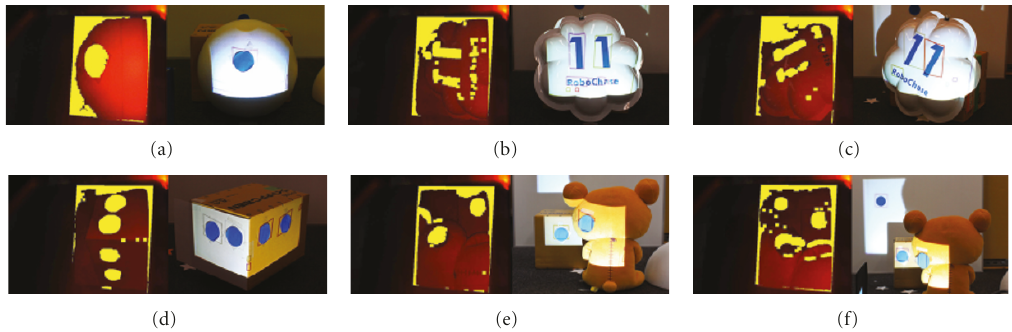
Figure 12: Demonstration of the proposed framework using 2-D Gabor filter as the base detector. Left images are images captured by the system camera with the multiscale detection result drawn in yellow. Right images are snapshots of the surface taken by a separate camera. All camera images were equally enhanced here for better